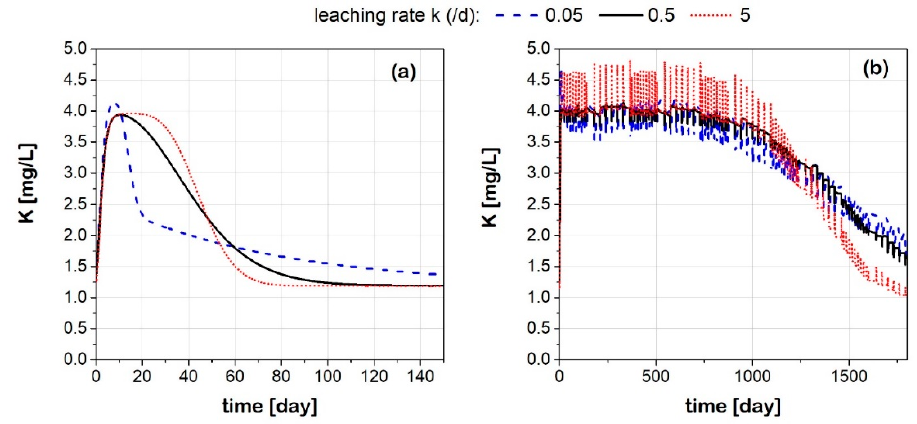
Figure 7. Effect of different values of the rate constant (k) in potassium release under ( a ) saturated and ( b ) unsaturated conditions.